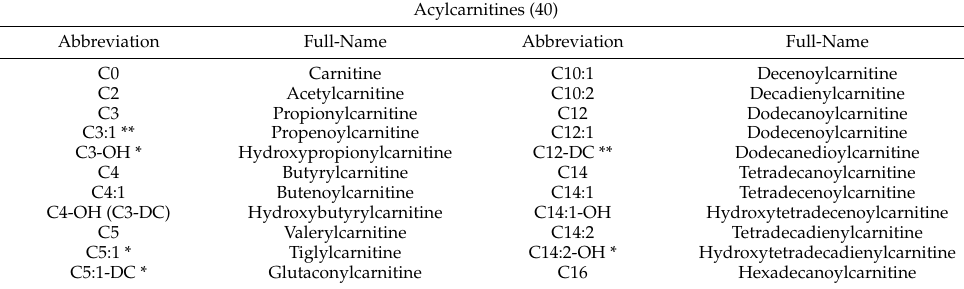
Table A1. List of metabolites measured with the AbsoluteIDQ ® p180 Kit GAC, Helmholtz Zentrum München. Note: Complete list of the 188 metabolites. With the asterisk (*) are marked the 33 metabolites excluded after selection as described in the method section. With the double-asterisk (**) are marked 8 metabolites included in the analyses for which only the variance between batches, but not within the batches, were only slightly above the predetermined cutoff prior normalization. Abbreviations: Cx:y indicates the lipid chain composition, where “x” is the number of carbons